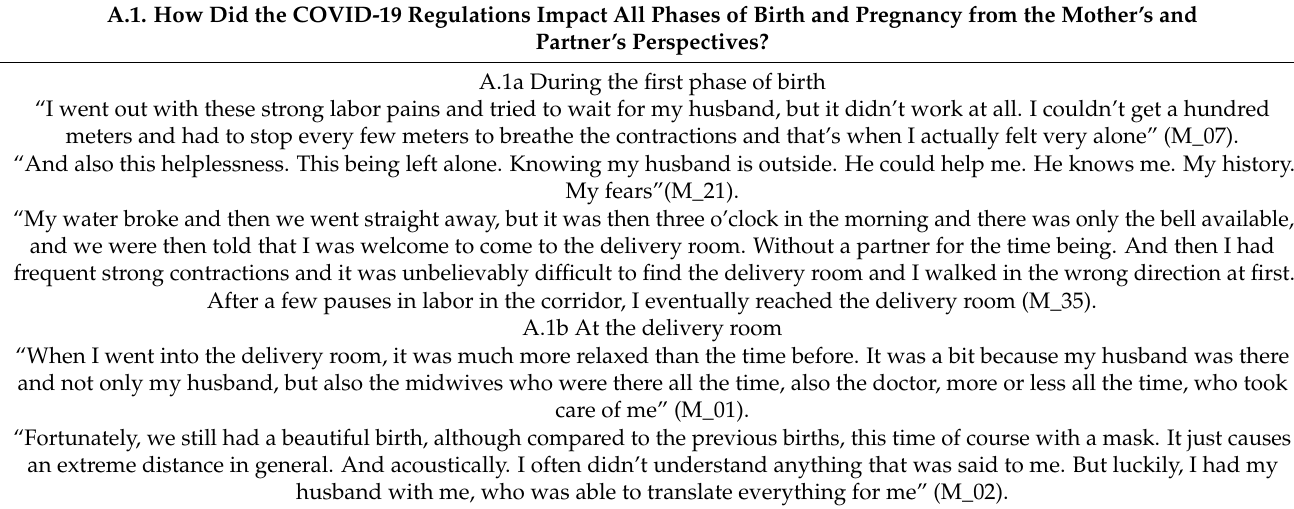
Table A1. Original quotes of mothers and partners